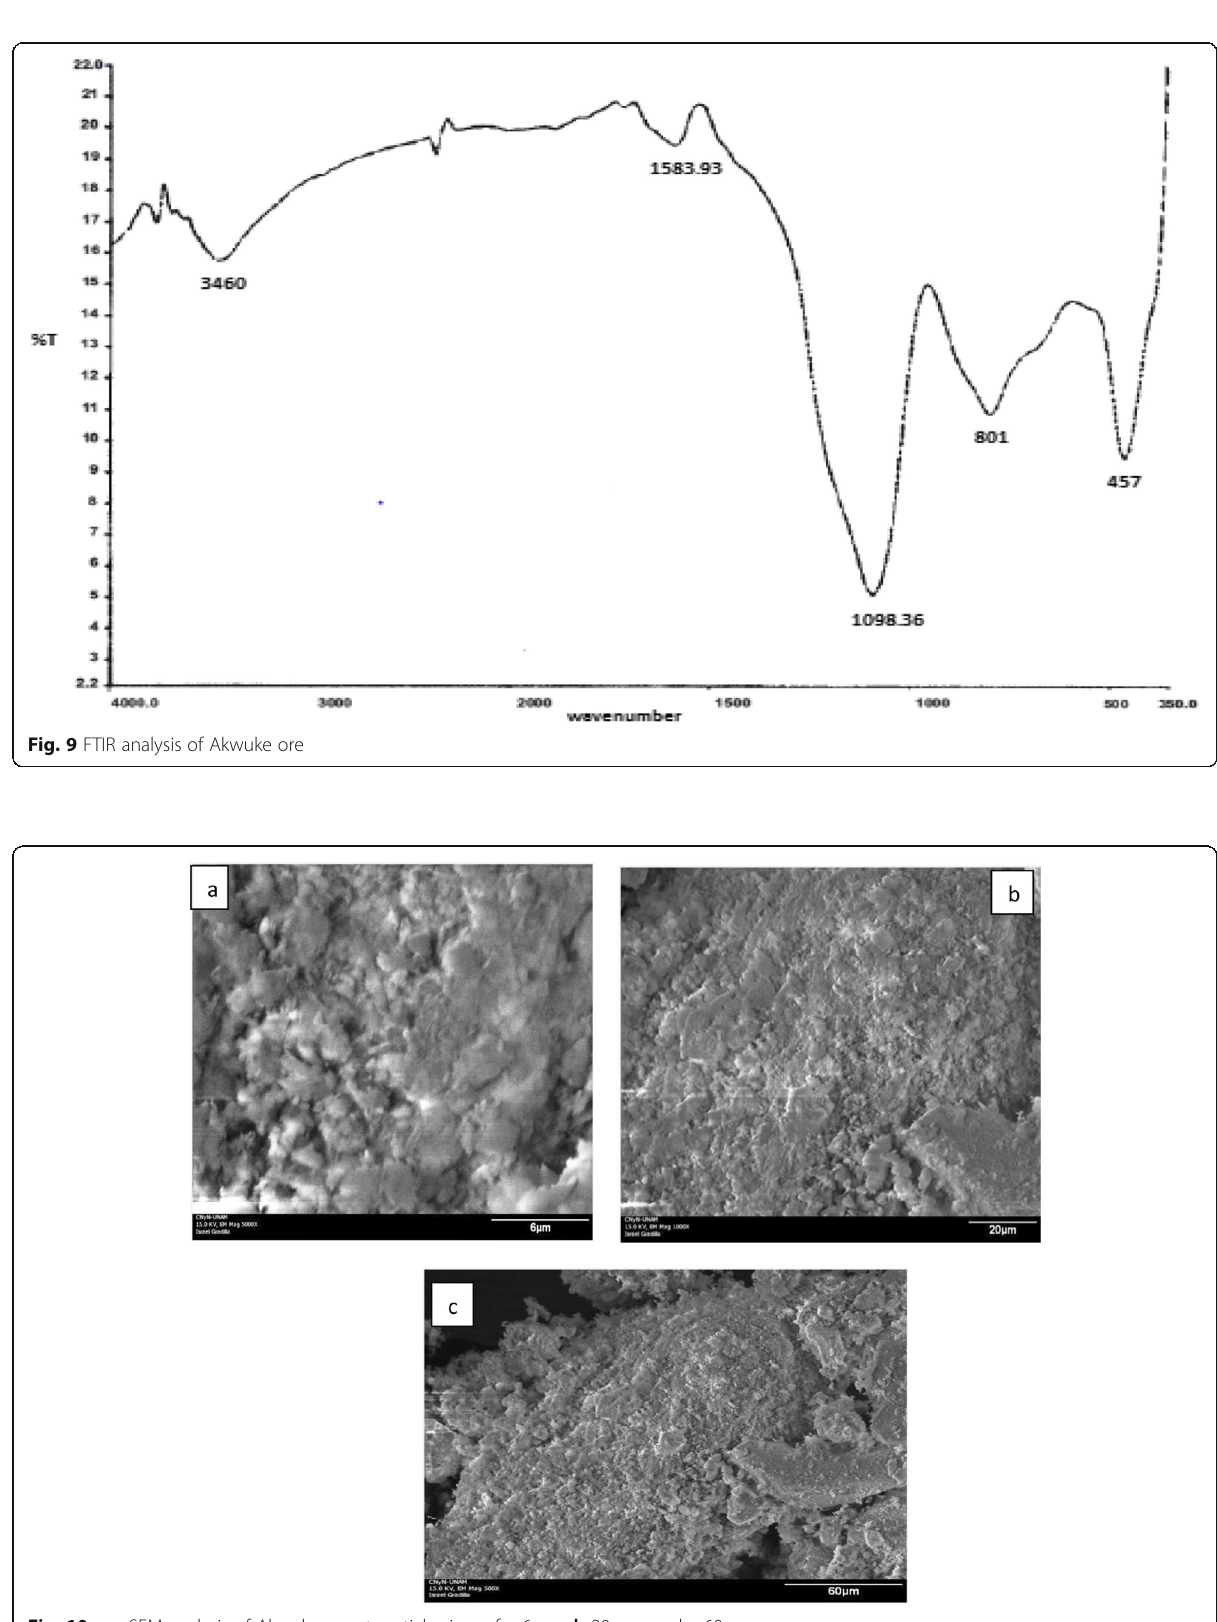
Fig. 10 a – c SEM analysis of Akwuke ore at particle sizes of a 6 μ m, b 20 μ m, and c 60 μ